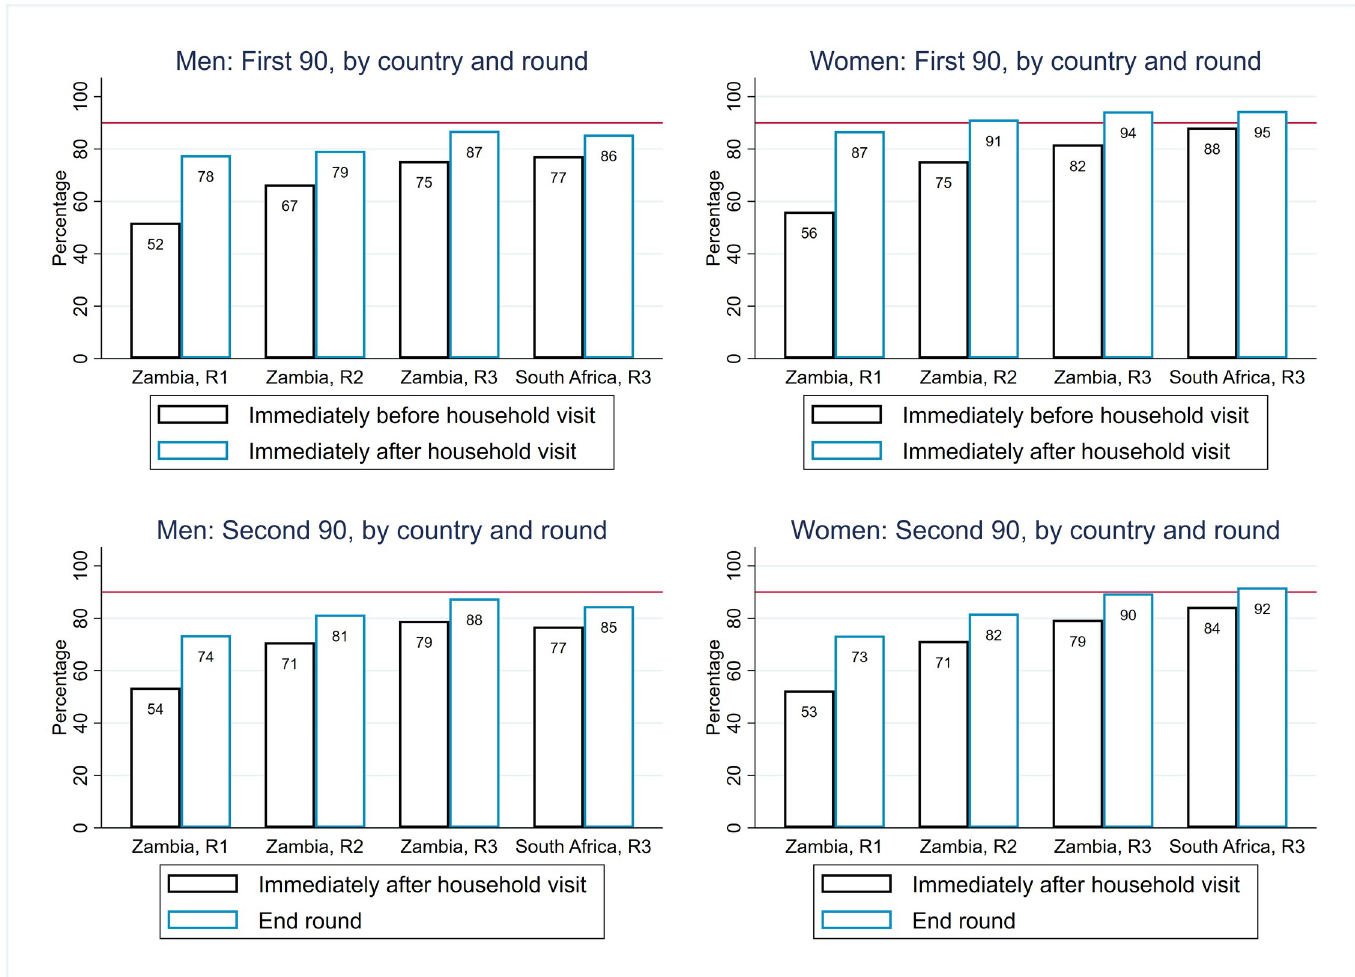
Fig 5. Arm A: Estimates of coverage against the first and second 90 targets, by sex, country, and round (with extrapolation to the total population). R1, Round 1; R2, Round 2; R3, Round